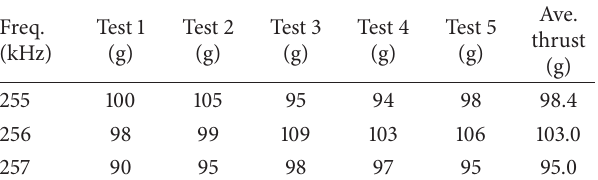
Table6:Thrustsofpiezoelectricactuatorcontainingdoublepushers (preload of 430g, drive voltage